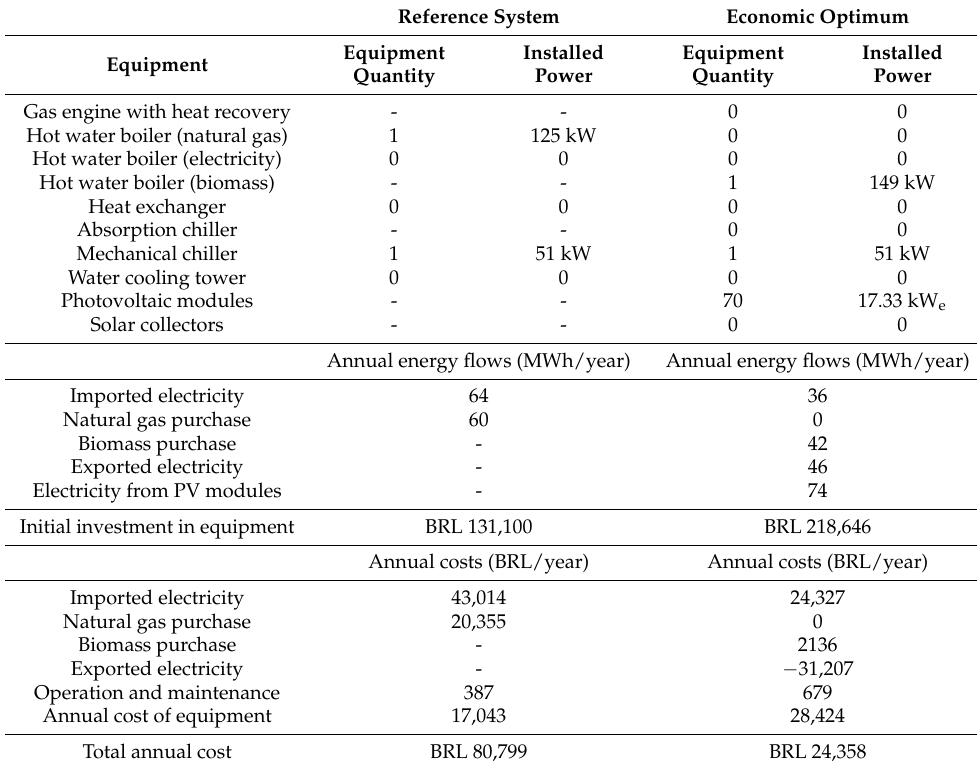
Table 4. Reference system vs. optimal economic